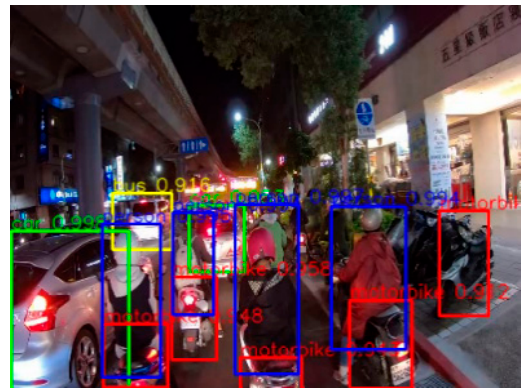
Figure 22. Inference on a 500 × 375-pixel nighttime image.